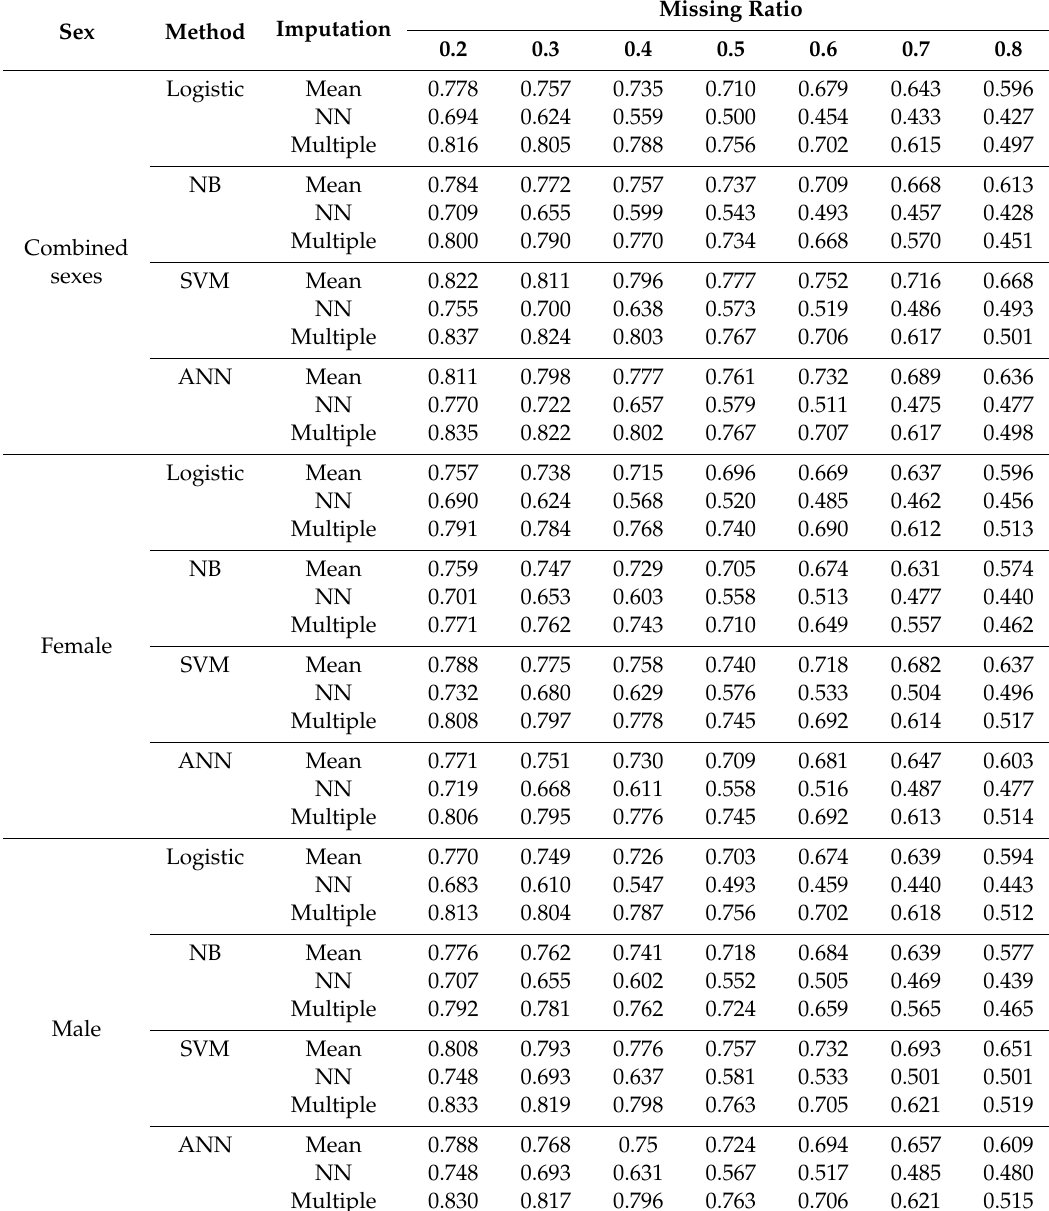
Table 3. Accuracy results by imputation method and learning algorithm: Lower